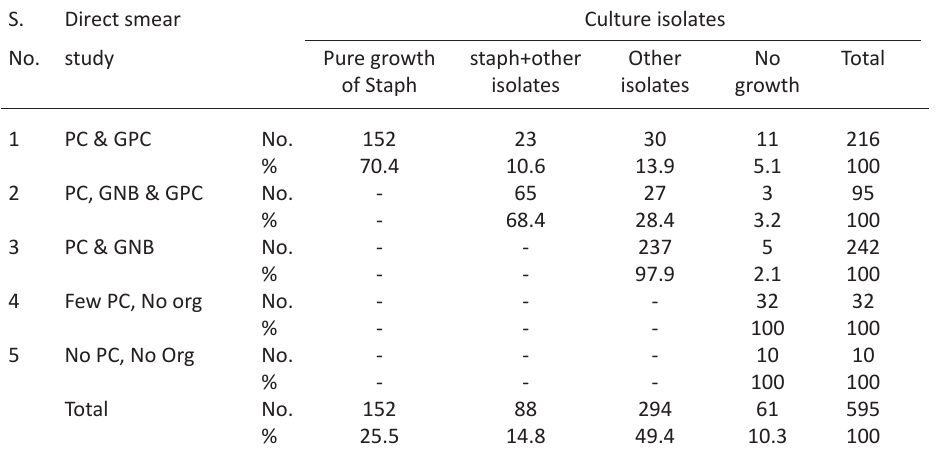
Table 2. Association between Direct smear study and culture S.